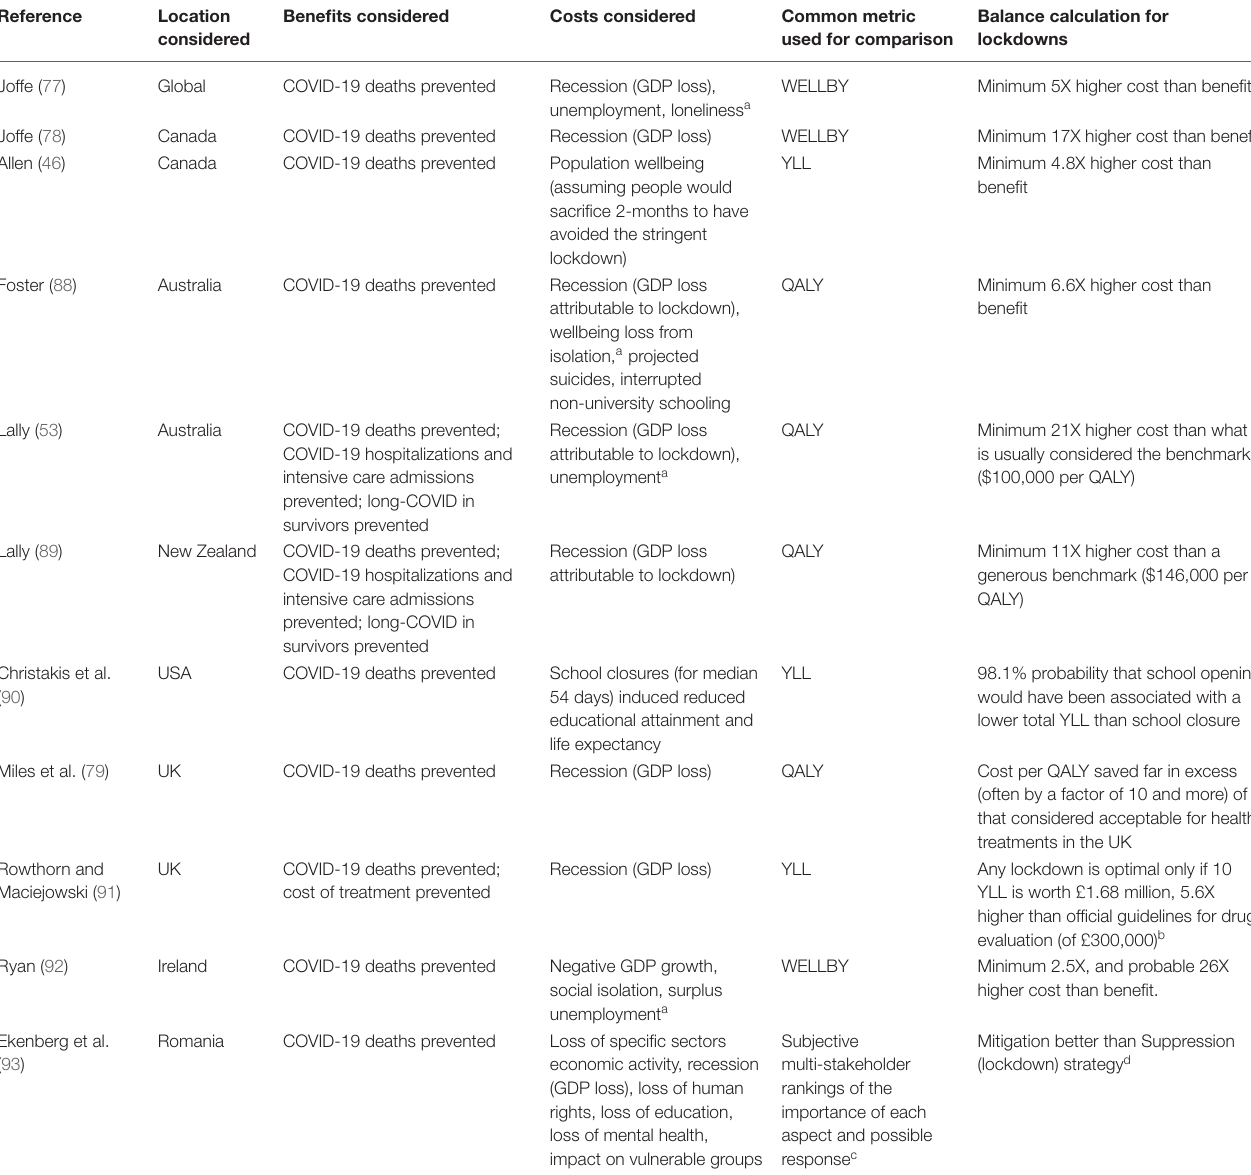
TABLE 5 | Cost-benefit analyses of lockdowns (assuming their efficacy) as the response to the pandemic.